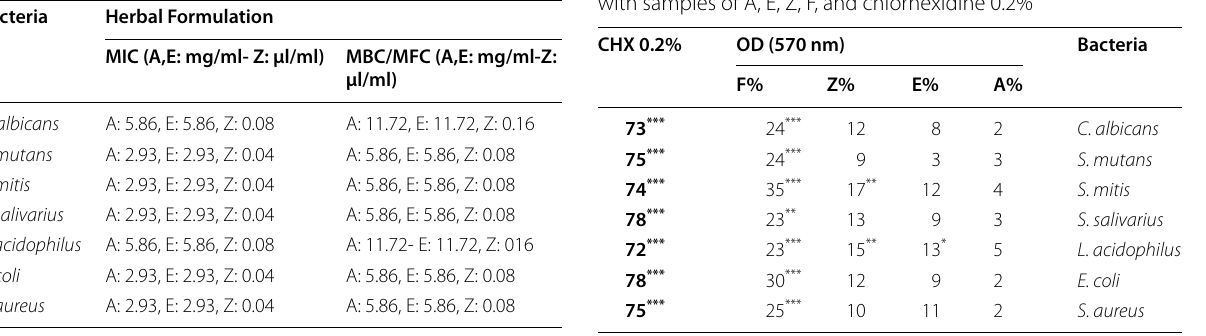
All samples were tested three times in independent experiments